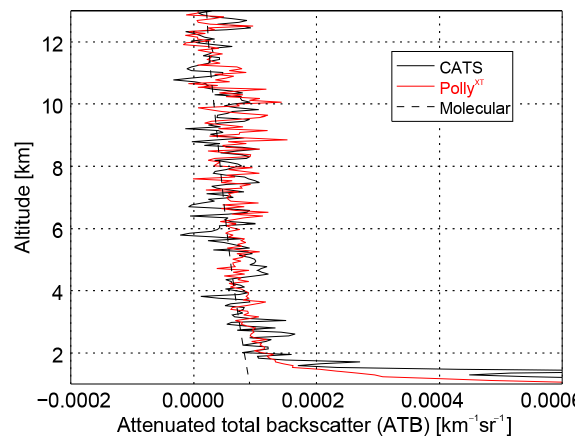
Figure 7. The mean CATS and Polly XT ATB profiles from the CATS overpass of the Leipzig, Germany, EARLINET site at 01:13:34UTC on 24 September 2015. CATS passed within 31km of the EARLINET site.